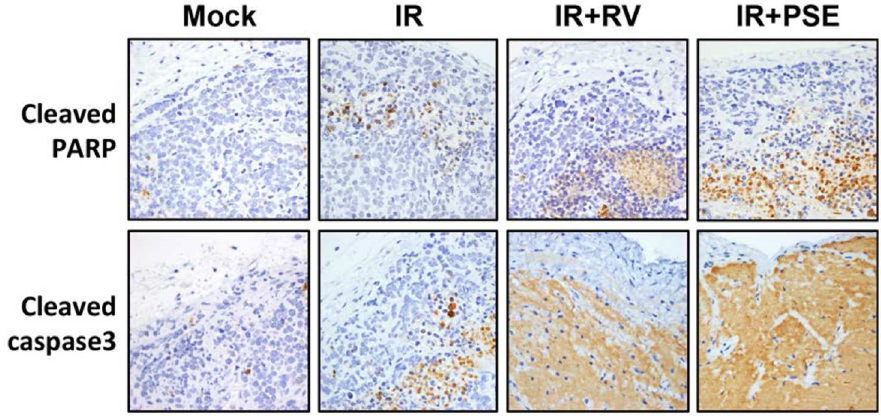
Fig 7. Representative immunohistochemical (IHC) staining patterns in xenograft prostate cancer tissue. IHC of paraffin sectionsshows stainingwith specific antibodies againstcleaved poly adenosine diphosphate (ADP) ribose polymerase (PARP) and caspase 3. Images were photographed at 200 ×